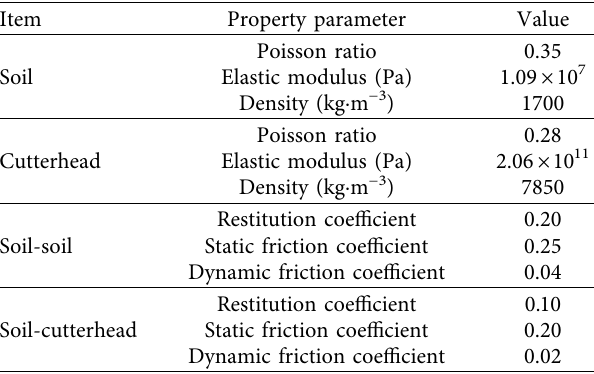
Figure 10: Simplified model of cutterheads. Table 3: Material parameters used in simulation.